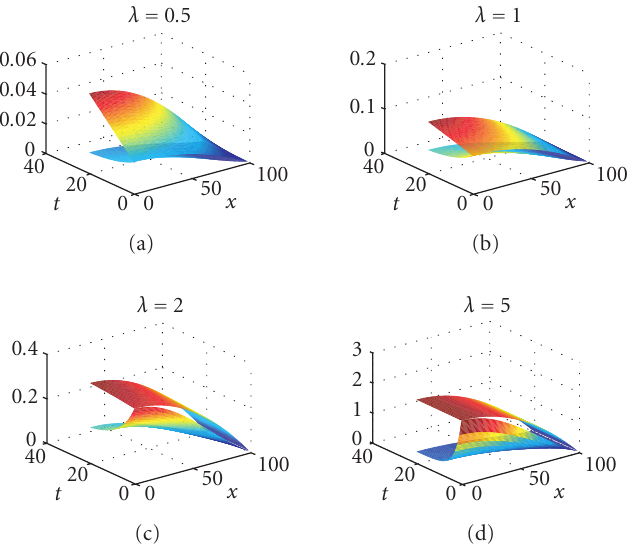
Figure 4.2. Upper and lower bounds for the spherical geometry, when β = 0 . 5, δ = 0 . 1, and λ = 0 .